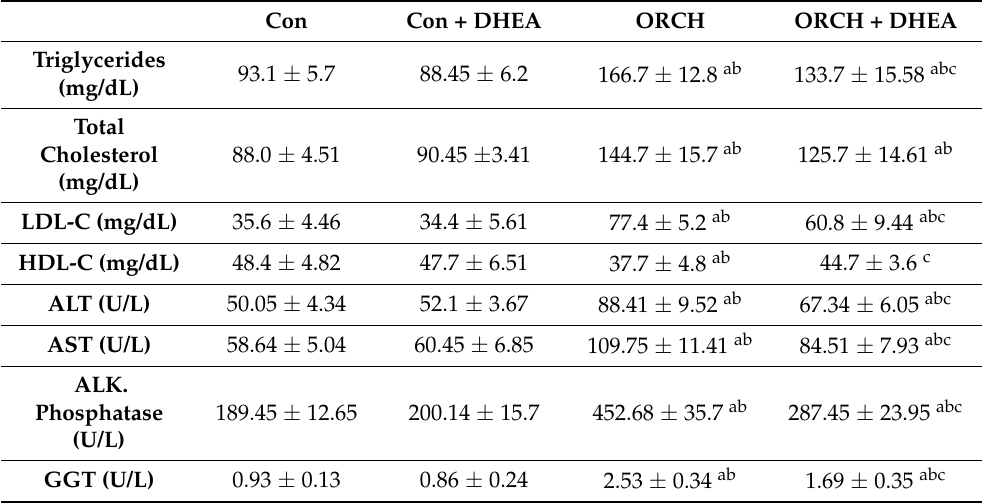
Table 2. Effect of DHEA on lipid profile and liver enzymes in orchidectomized